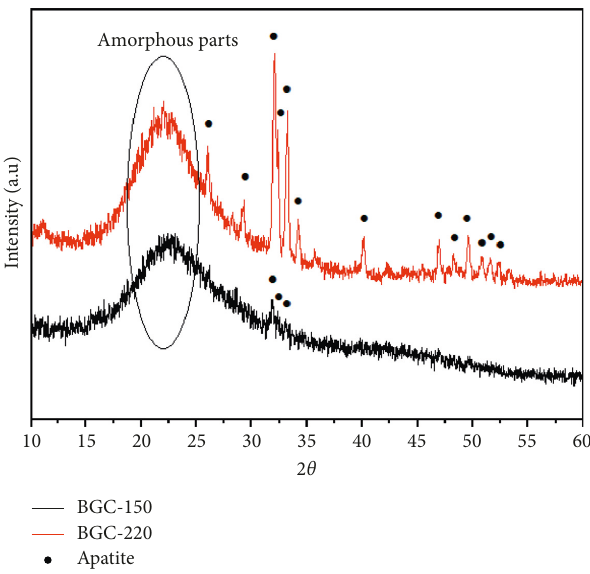
Figure 1: XRD diagrams of BGC-150 and BGC-220